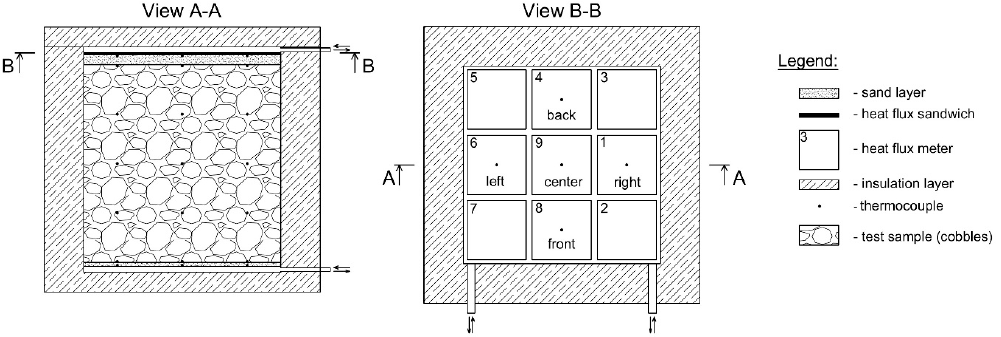
Figure 11. Experimental test setup: A-A vertical cross-sectional view; B-B horizontal cross-sectional view at heat flux sensor level (Rieksts et al., 2017 [27]).